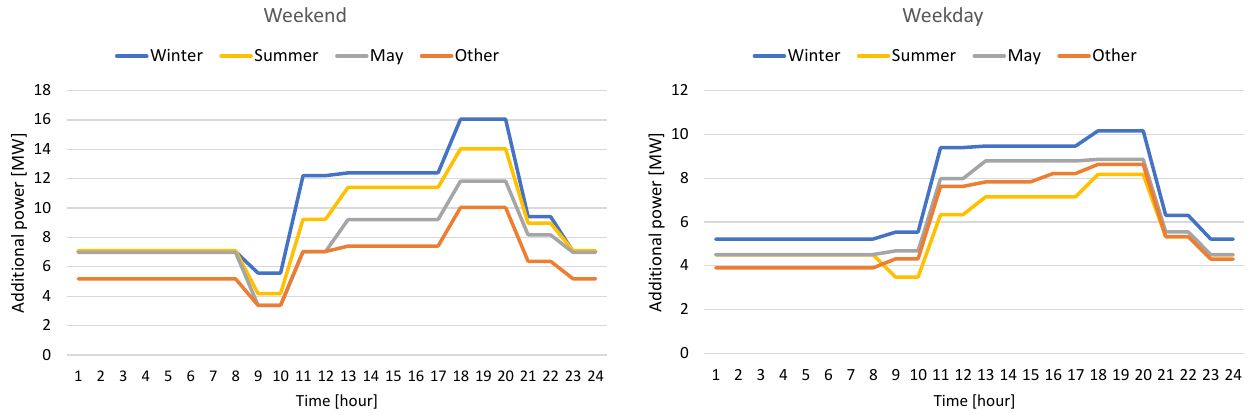
Figure 9. Additional load curve for scenario 3 ( home and shopping on-the-road charging ). Winter = No- vember–March, summer = June–August, and other = April, September, and October.